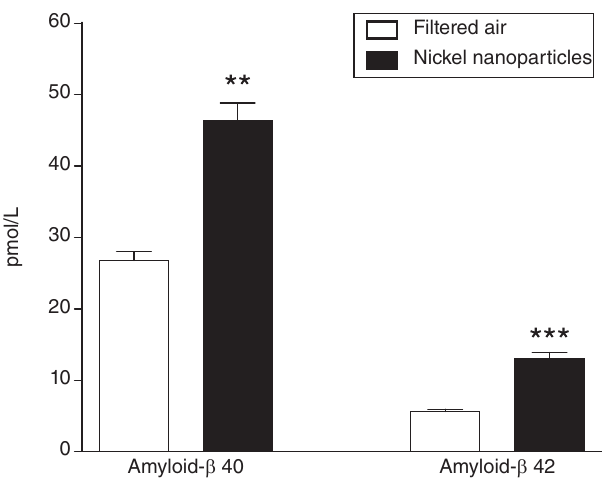
Figure 1. Exposure to air pollution increases amyloid- β (A β ) levels in the mouse brain. Elevated endogenous mouse brain A β 40 and A β 42 in mice exposed to nickel nanoparticles (count median diameter 54 nm, at 1 mg/m 3 ) ( n = 16 per group) versus filtered air ( n = 5 per group) for 3 hours in a nose-only exposure chamber. Data presented as mean + SEM. ** P < 0.01, *** P < 0.001 (Mann-Whitney